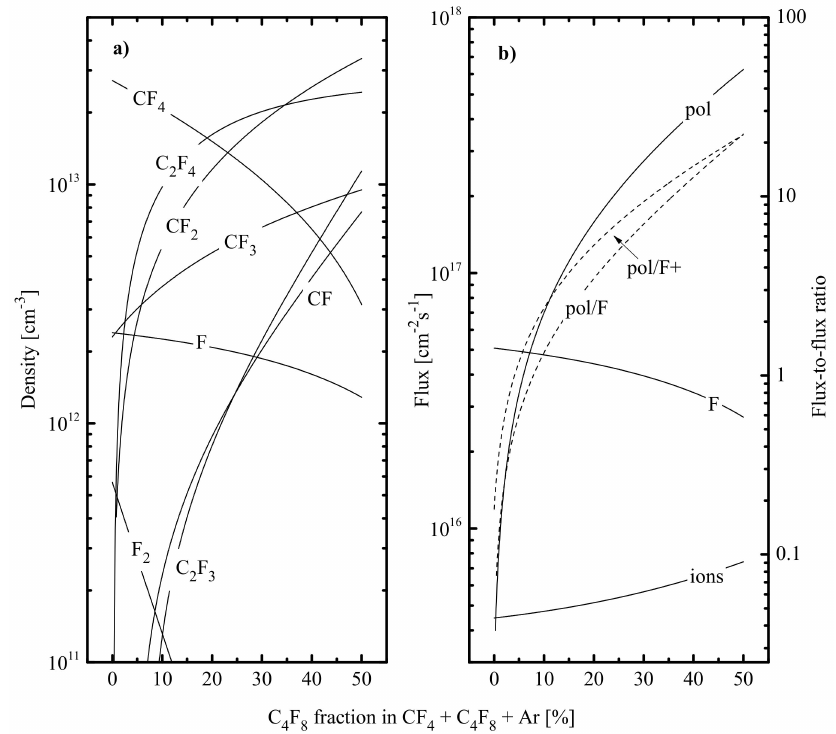
Figure 6. Densities ( a ), fluxes (b, solid lines) and flux-to-flux ratios (b, dashed lines) of active species in CF 4 + C 4 F 8 + Ar plasma at p = 4 mTorr, W = 800 W, W dc = 150 W and y Ar = 50%. In ( b ): “pol”—polymerizing radicals; “F”—fluorine atoms; “ions”—positive ions; “pol/F”— Γ pol / Γ F ratio characterizing polymer deposition rate; “pol/F+”—parameter Γ pol /